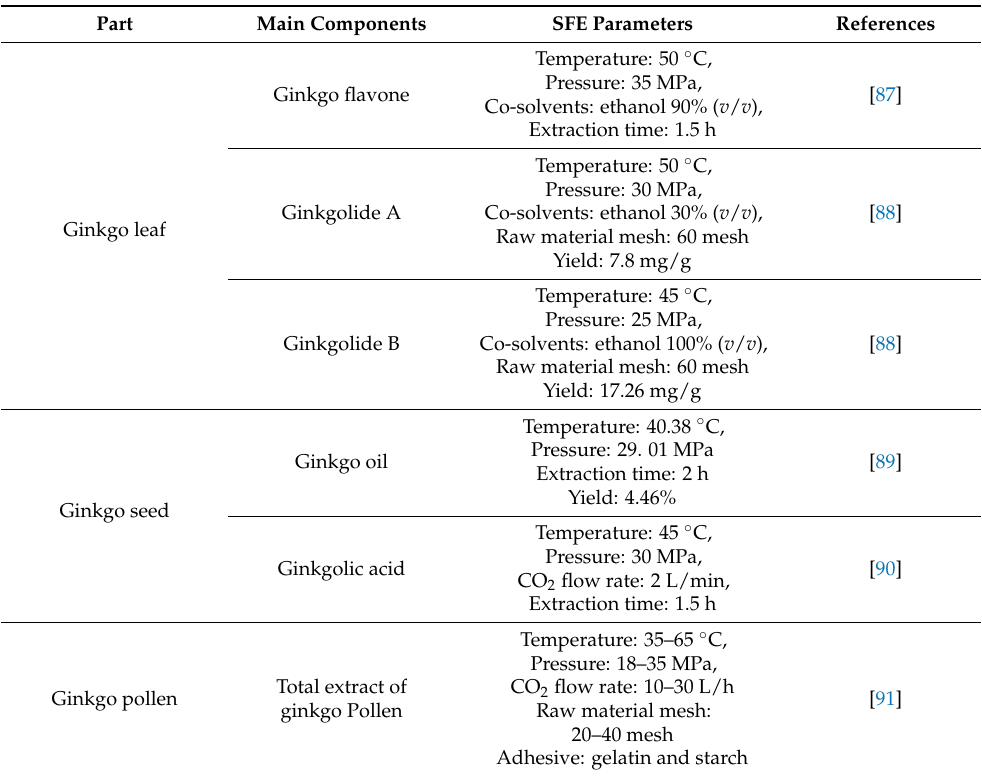
Table 2. Application of SFE-CO 2 to extract active components from different parts of Ginkgo biloba